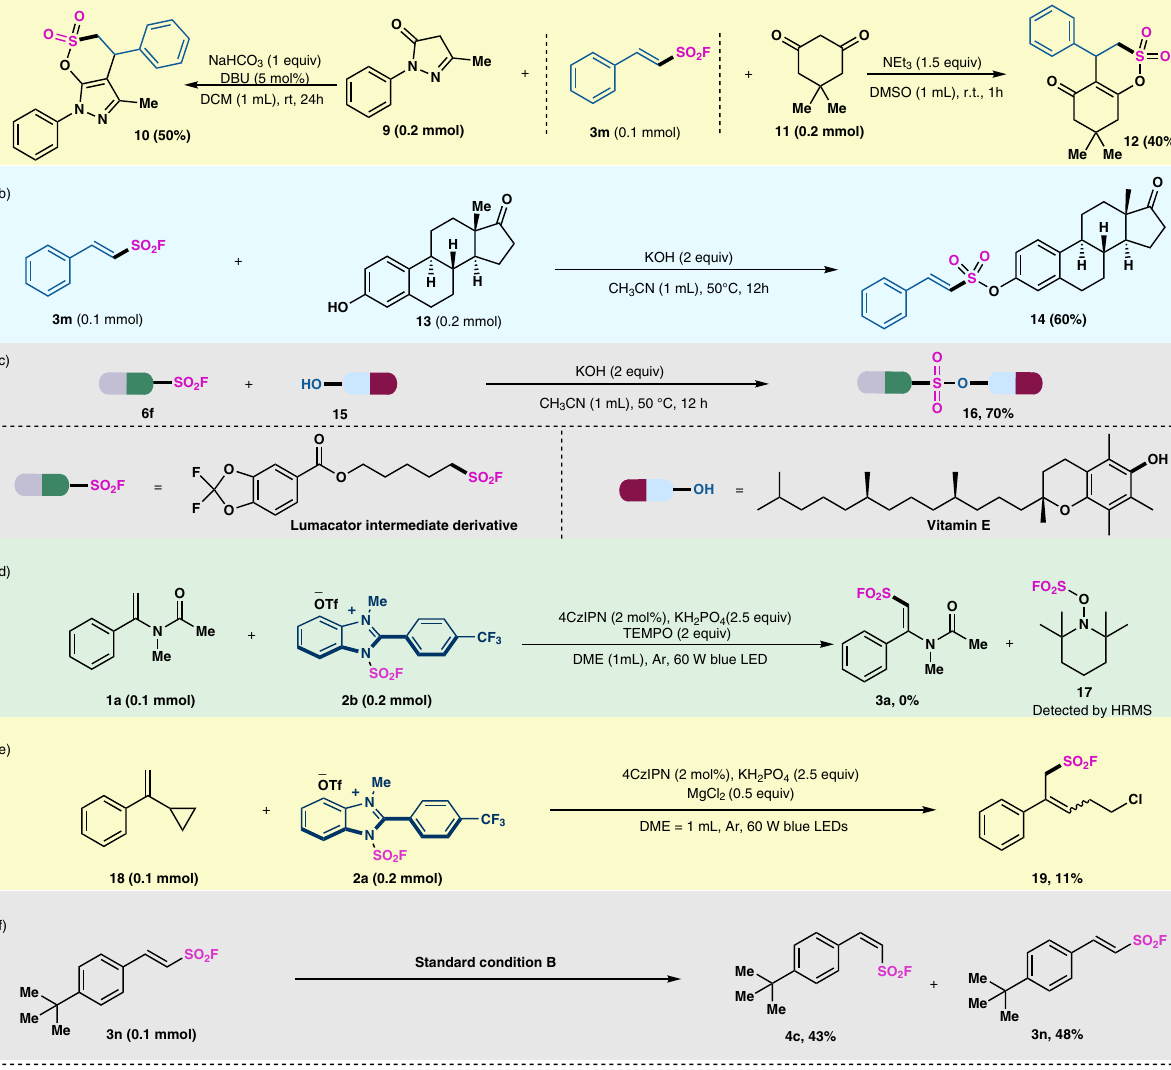
NATURE COMMUNICATIONS| (2022) 13:3515